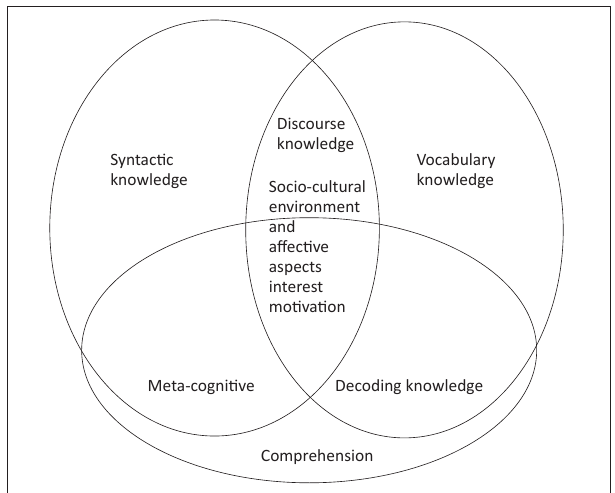
FIGURE 1: Interactive model of the reading